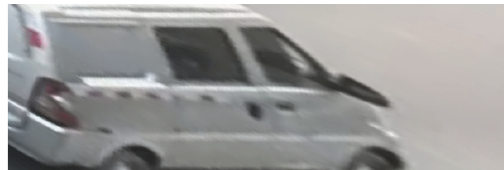
Figure 35: The inverse projection of the left view of